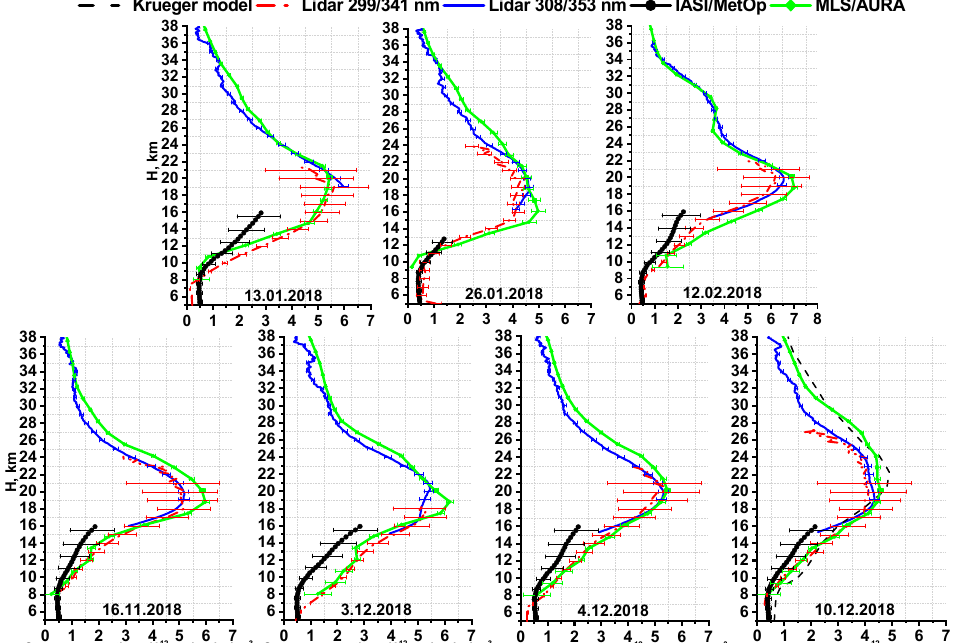
Figure 10. Comparison of ozone vertical profiles in the upper troposphere–stratosphere with Aura and MetOp satellite data.